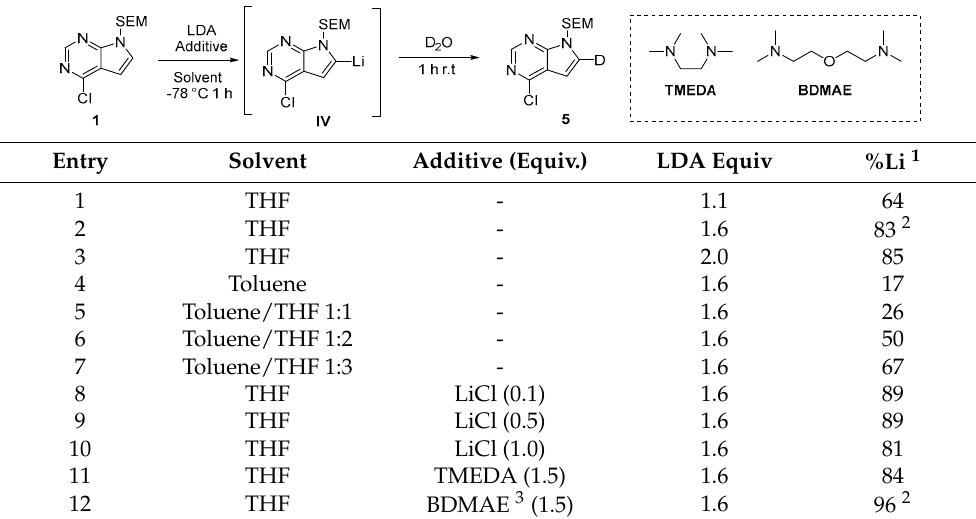
Figure 1. Comparison of the storage stability of lithiated intermediate IV in THF. Green circles: − 78 °C with BDMAE as additive, blue squares: − 78 °C no additive, orange triangles: − 40 °C no additive, red rotated square: − 10 °C. The % lithiation was monitored indirectly by 1 H NMR following a 1 h quench with D 2 O at 22 °C under sonification. Table 1. Effect amount of LDA, toluene and additives on the lithiation process.